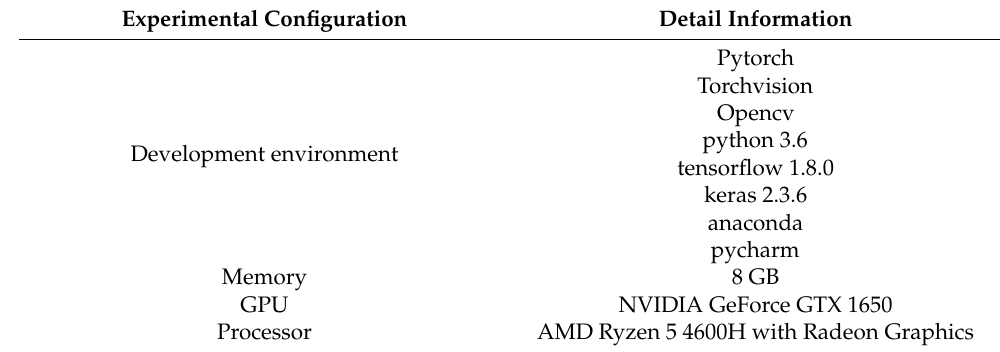
Table 3. Experimental configurations.